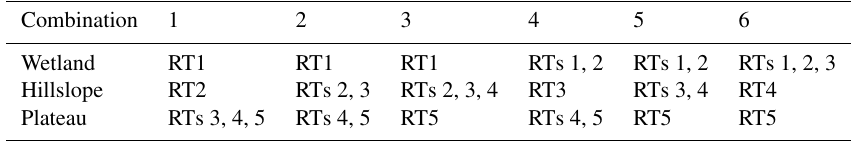
Table A1. Reclassification of the reference maps for the class comparison with the GH11 maps.